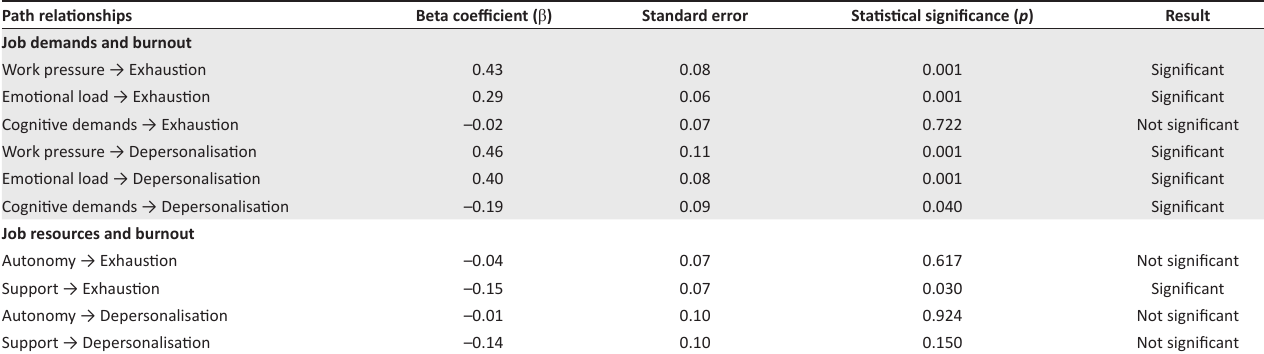
TABLE 2: Structural relationships of job characteristics with burnout. Path